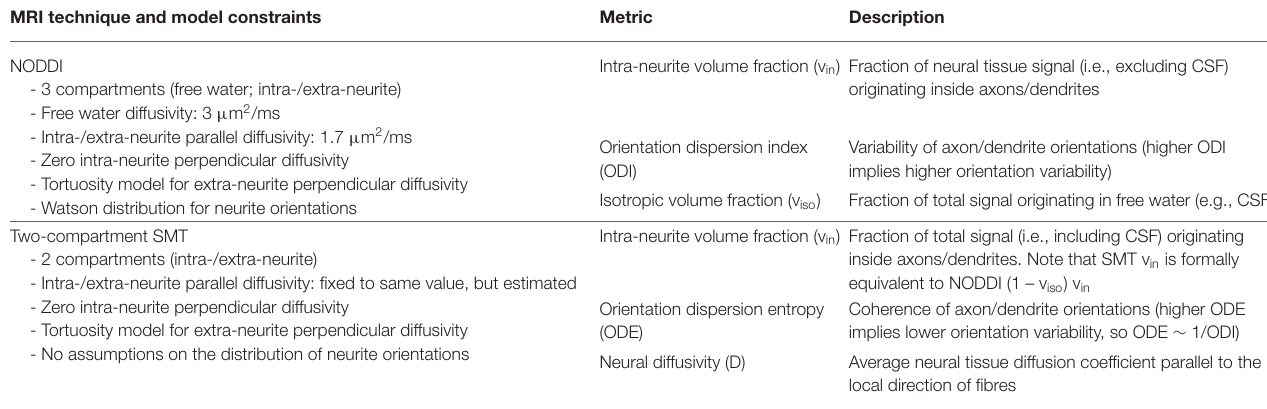
TABLE 1 | Summary of the diffusion MRI metrics provided by the NODDI and SMT techniques, as well as overview of the constraints adopted in each of the two models. MRI technique and model constraints Metric